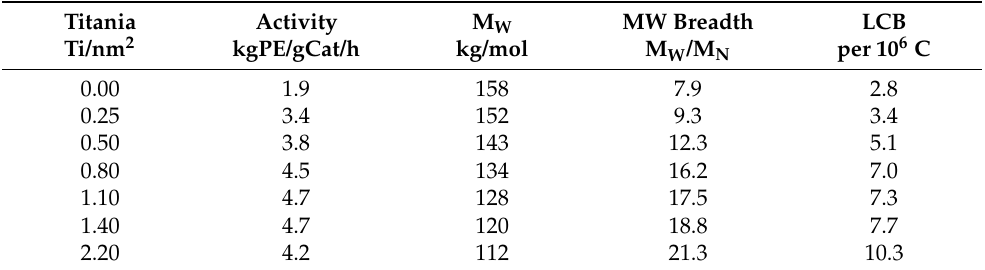
Table 1. The influence of titania, when applied to Cr/silica, on the catalyst activity and resultant polymer